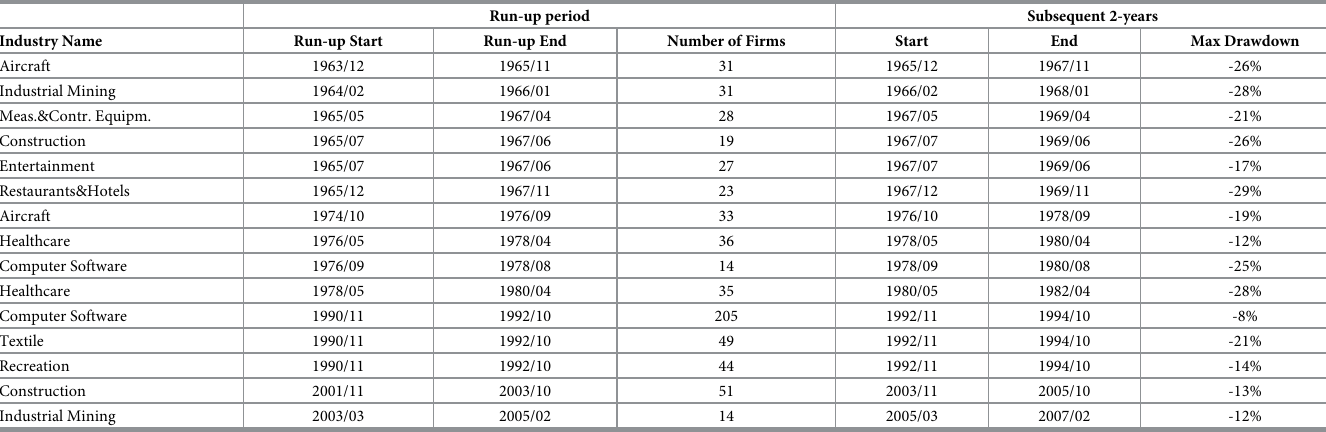
Table 2. Industry price run-ups–non-crashes.